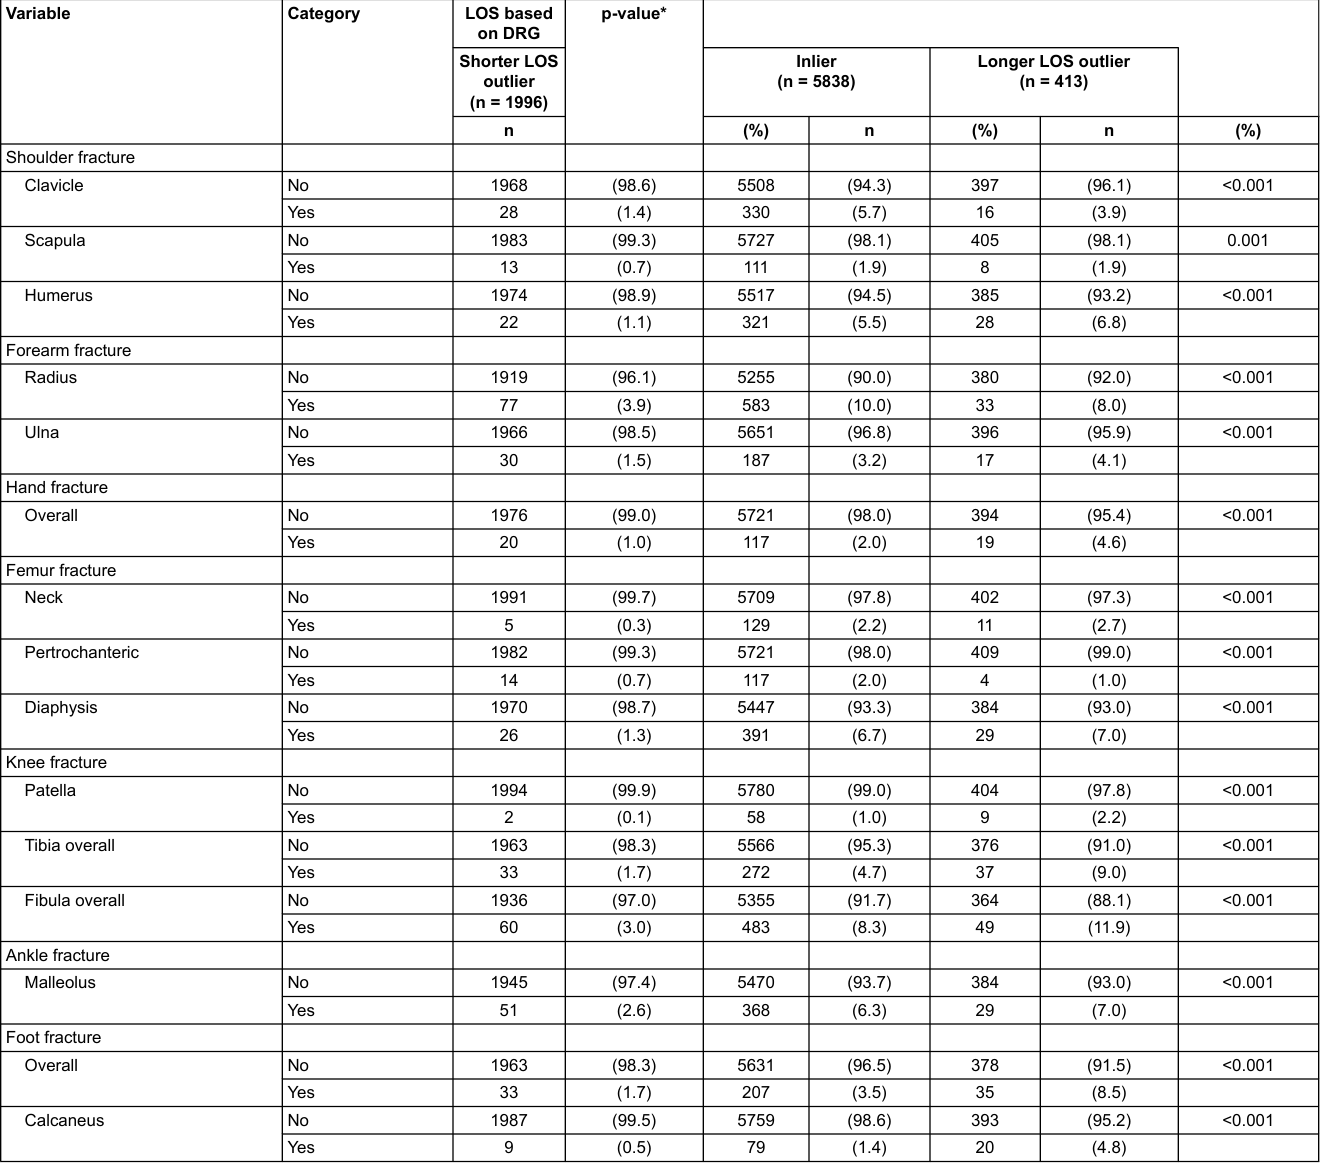
Table 3: Extremity fractures according to the length of hospital stay (LOS) based on diagnosis related group (DRG) (n = 8247).